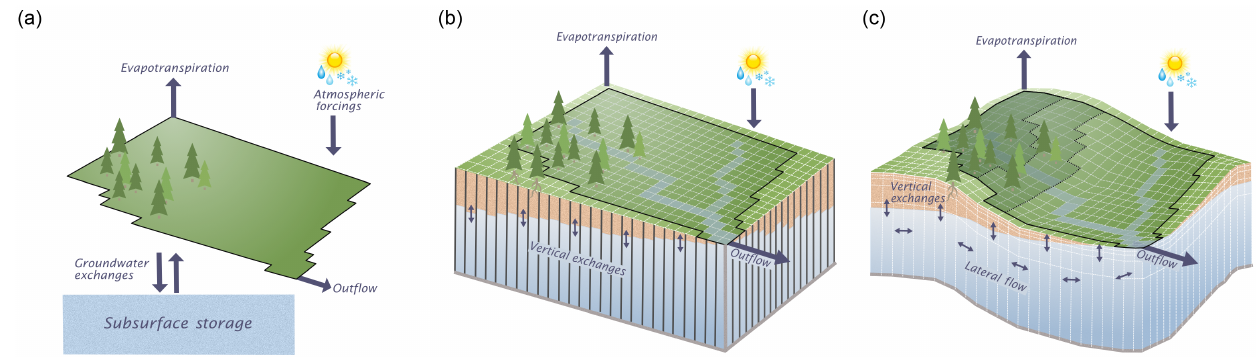
Figure 1. Conceptual illustration of (a) lumped parameter hydrologic models, (b) land surface models with vertical subsurface exchanges and (c) integrated hydrologic models. The nested subbasin approach is also illustrated on (c) using the black outlines for